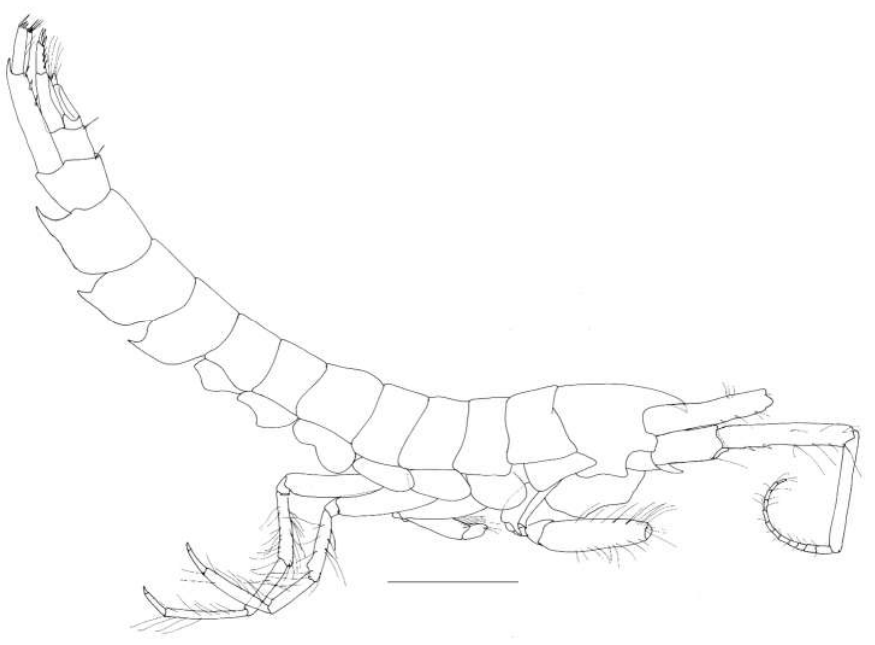
Figure 13. Unciola icelandica sp. nov. paratype female, 6 mm, ZMHK 62086, South Island, Iceland Basin, 1921 m. Scale: 1 mm.